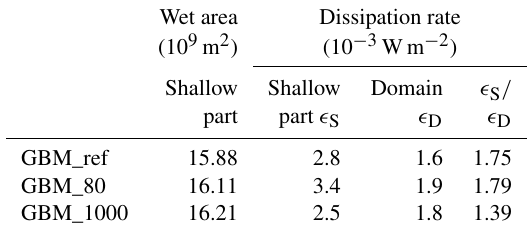
Table 4. Mean flooded area at tidal high water (wet area) in the shallow part of the German Bight out to 20m depth, dissipation rate (cid:15) S averaged in the shallow part of the German Bight out to 20m depth and dissipation rate (cid:15) G averaged over the entire German Bight Model domain excluding the